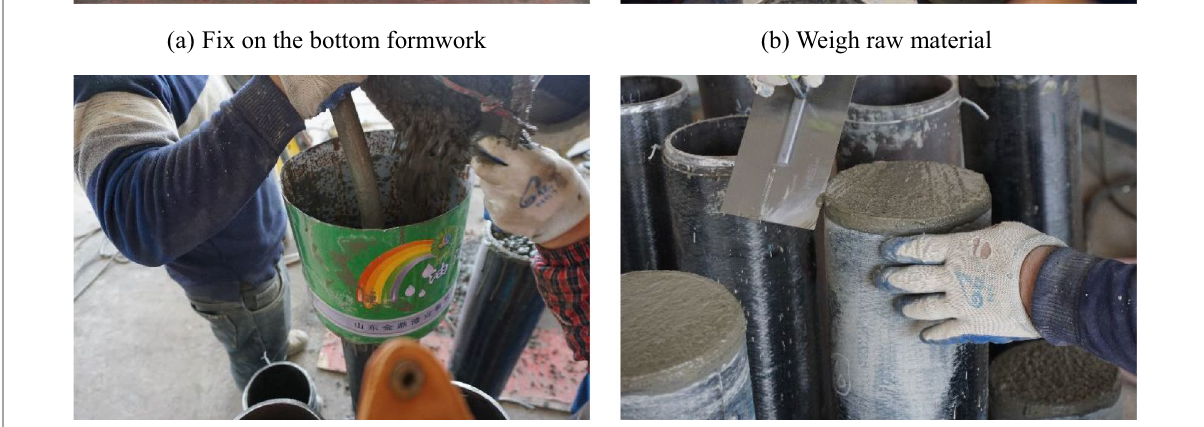
strips with thicknesses of 3.0 mm and 6.0 mm were 489.9 and 472.3 MPa. The ultimate tensile strength, ultimate tensile strain and elastic modulus of the FRP were 3406.4 MPa, 0.013 and 269.4 GPa.